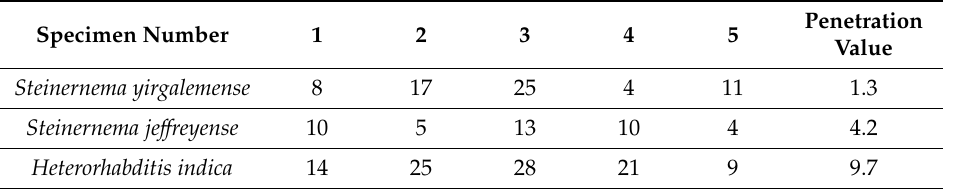
Table3. Numberofnematodesfoundper Cacoscelesnewmannii larvainoculatedwithahighconcentration of IJs, for the three nematodes species used.